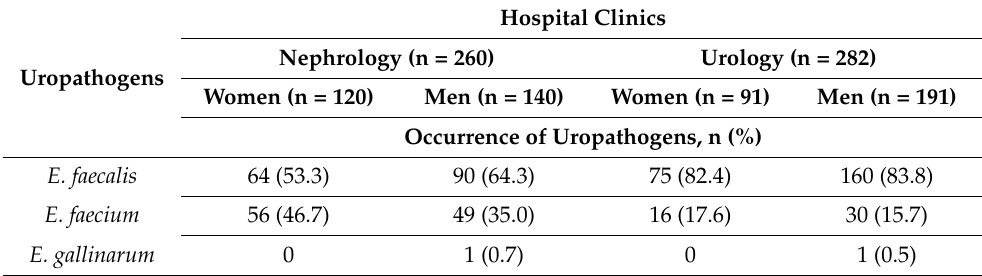
Table 2. The prevalence of enterococcal strains isolated from the urine of patients hospitalized in Nephrology and Urology clinics over the years 2016–2021 and their species distribution in different gender groups (n =